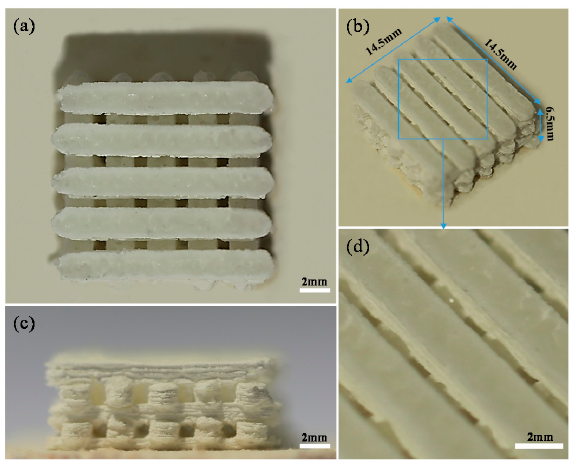
Figure 5. The scaffold with 20 wt % CaSiO 3 : ( a ) top view; ( b ) isometric view; ( c ) lateral view; and ( d ) enlarged partial view.